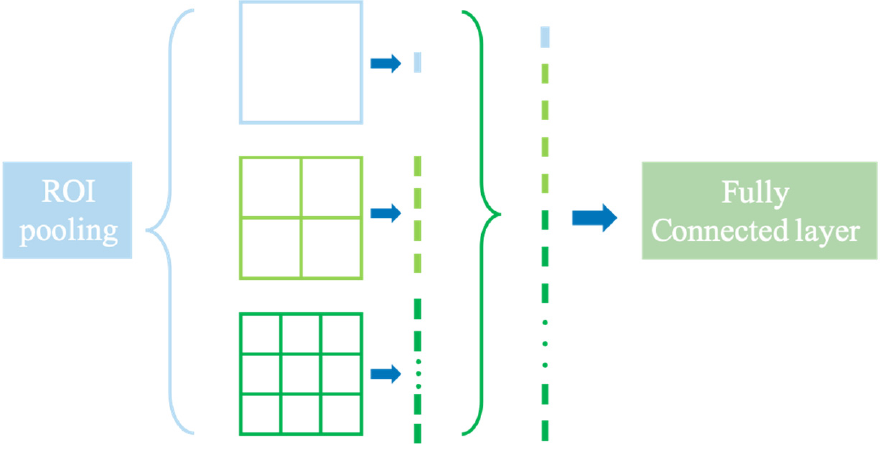
Figure 5. Multi-level ROI pooling layer.